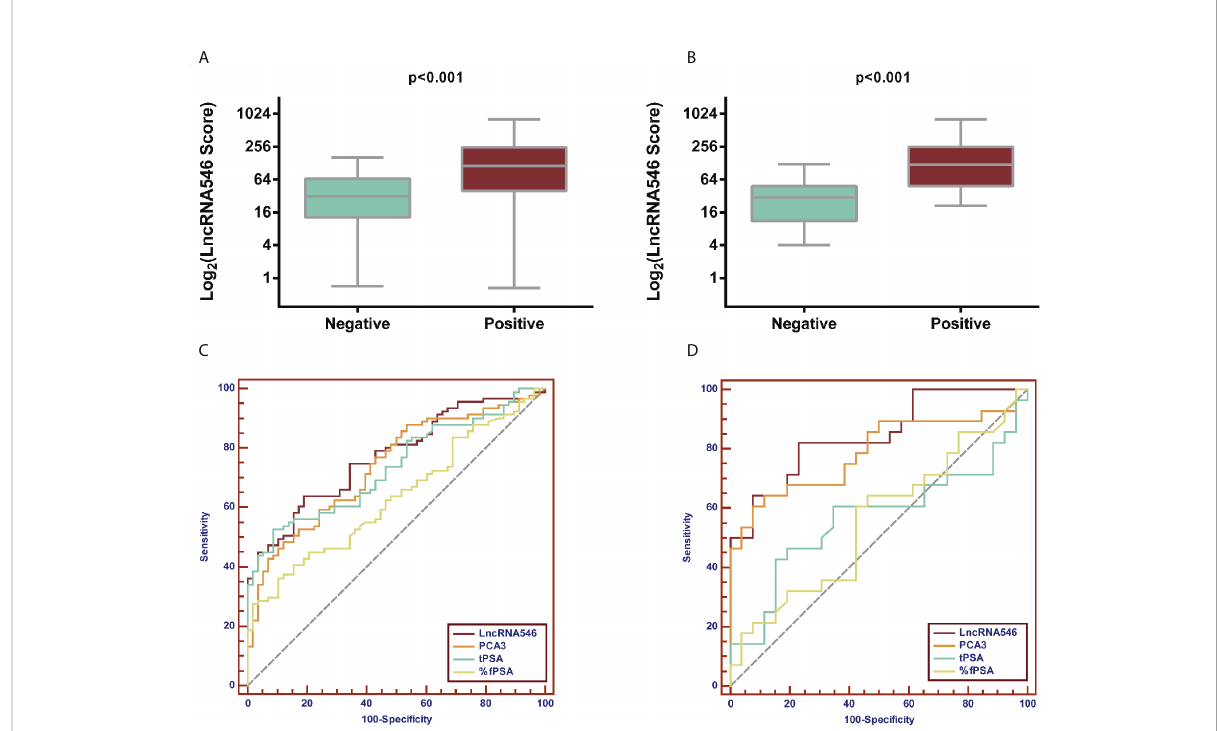
FIGURE 5 Validation of diagnostic performance of LncRNA546 from multicenter data. LncRNA546 score between positive and negative biopsy groups in the overall cohort (A) and in the PSA gray area cohort (B) . ROC curves for LncRNA546 compared with PCA3, tPSA and %fPSA in the overall cohort (C) and PSA gray area cohort (D)